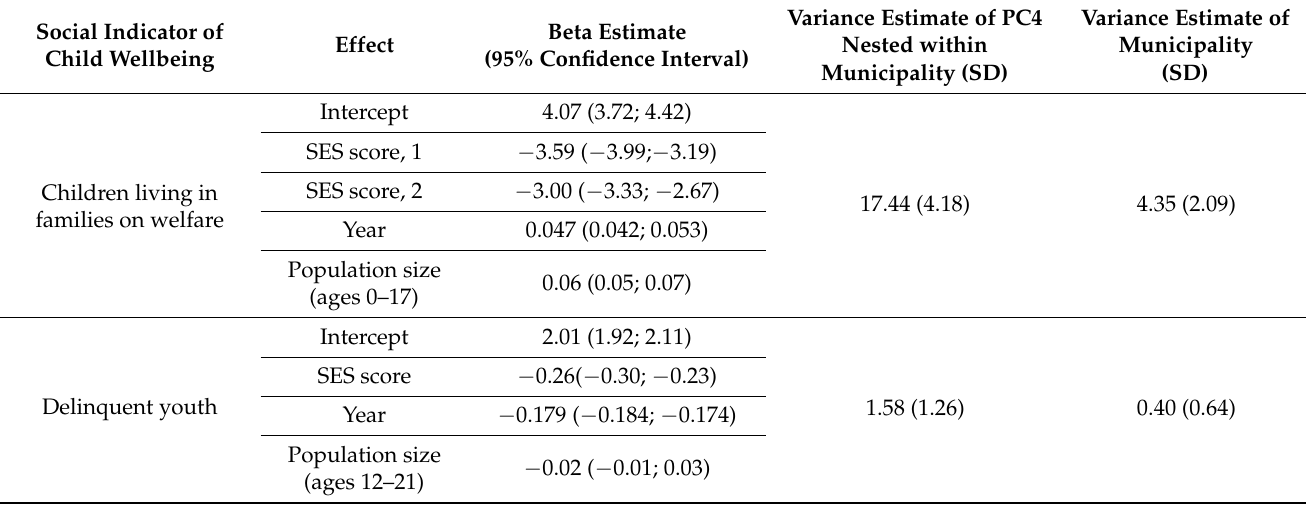
Table 3. Results of the main outcome measures, weighted for the number of children or adolescents per neighbourhood ( n =